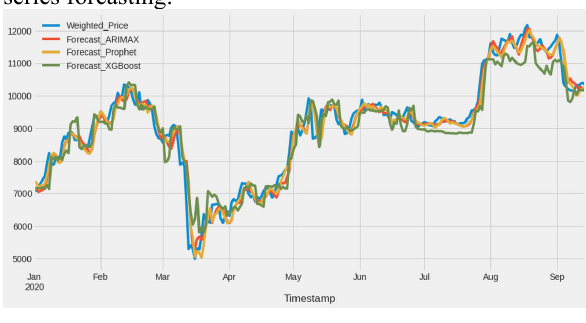
Figure 10. Comparative Analysis of ARIMAX, FBProp and XGBoost